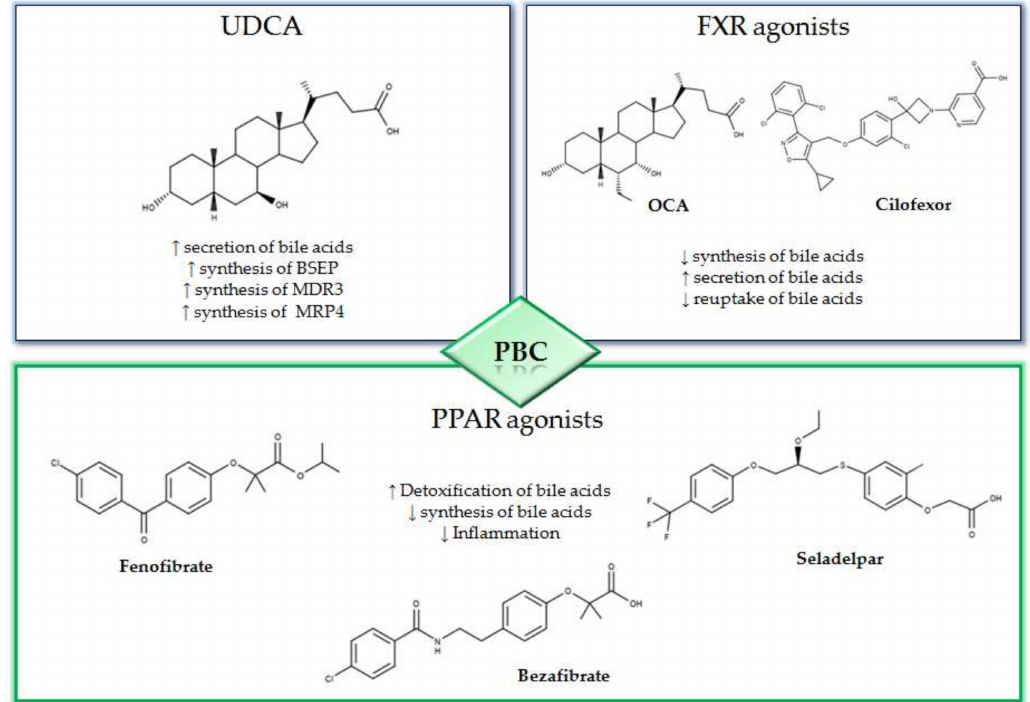
Figure 1. Mechanisms and 2D structures of Ursodeoxycholic acid (UDCA), Obeticholic acid (OCA), Cilofexor, Fenofibrate, Bezafibrate and